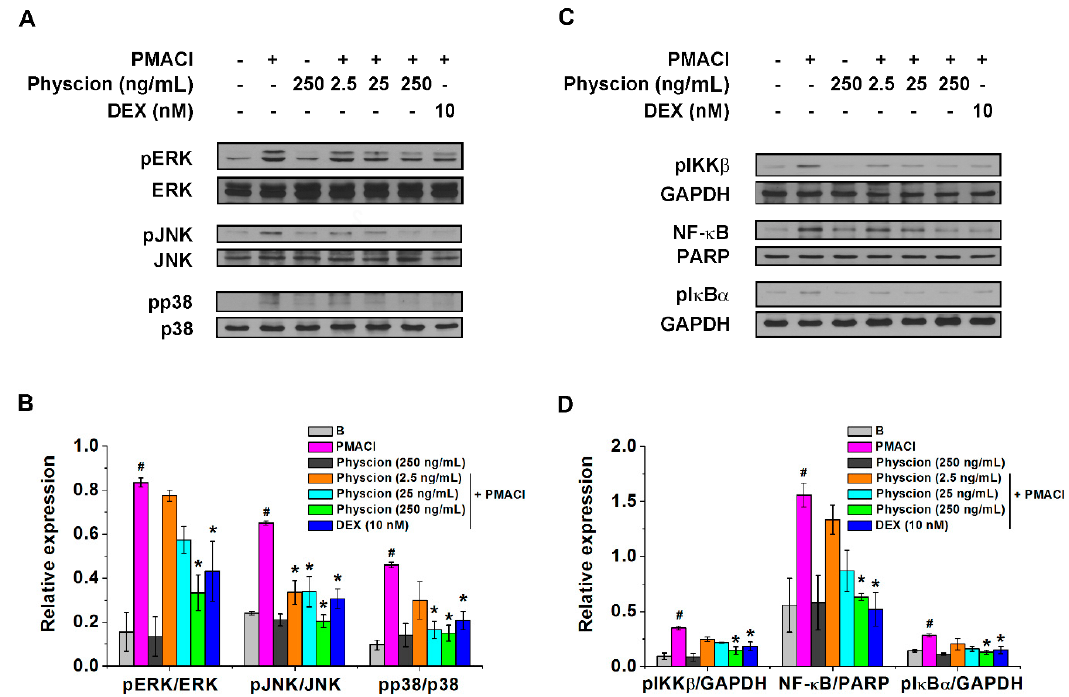
4 of 16 Figure 3. Physcion down-regulates RIP2 and caspase-1 expressions in PMACI-stimulated HMC-1 cells. ( A ) HMC-1 cells (5 × 10 6 ) were treated with physcion or DEX for 1 h and then stimulated with PMACI for 30 min. Representative immunoblots are shown. ( B ) Each relative intensity of protein levels was quantified by densitometry and shown as RIP2/GAPDH and caspase-1/GAPDH. ( C ) Caspase-1 activity was determined with a caspase-1 assay kit. # p < 0.05 vs a non-stimulated group. * p < 0.05 vs a PMACI-stimulated group. 2.3. Physcion Attenuates phospho (p)ERK/pJNK/pp38 And pIKK β /NF- κ B/pIkB ɑ Expressions in PMACI- Stimulated HMC-1 Cells We next wished to identify whether physcion would modulate mitogen-activated protein kinase (MAPK)s and pIKK β /NF- κ B/pIkB α expression levels because TSLP levels secreted from HMC-1 cells are regulated via MAPKs/NF- κ B signaling pathways [15,22]. The stimulation with PMACI induced significant increases in the expression levels of pERK, pJNK, and pp38 MAPKs compared to those of